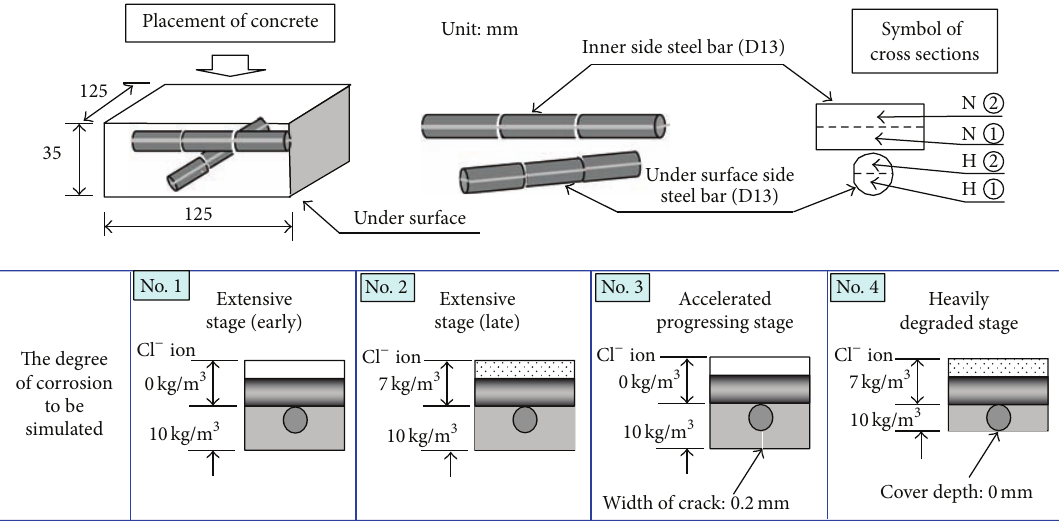
Figure 3: Measurements of current density in steel bars with progressing degree of corrosion.